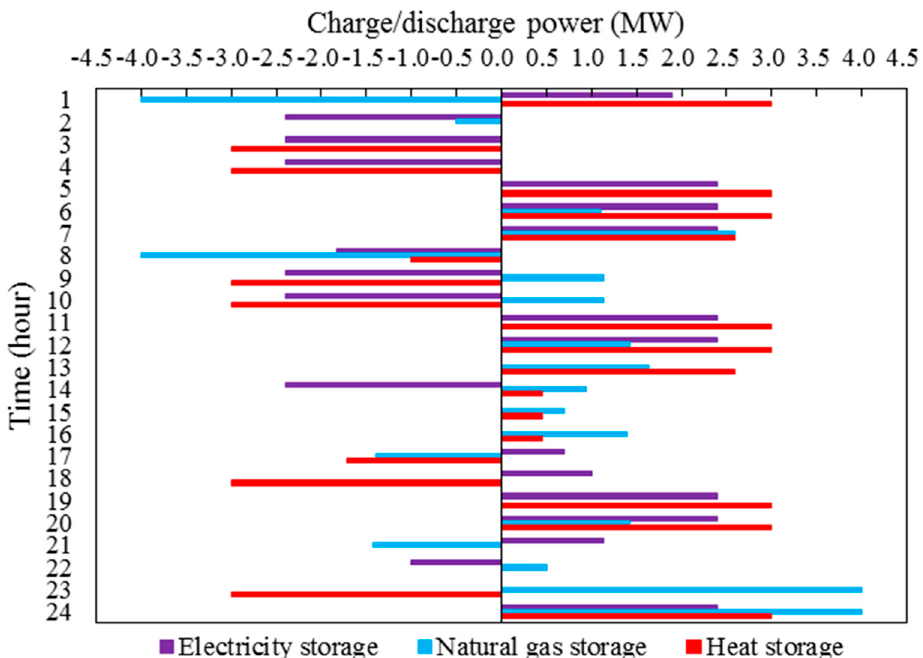
Figure 6. Change of diversified storage devices charge/discharge for EH1. Energies 2018 , 11 , x